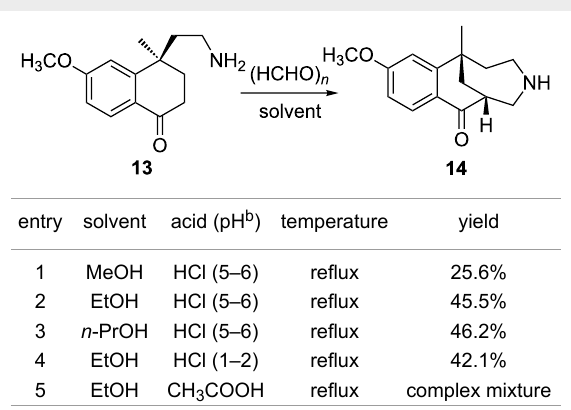
Table 3: Optimization of Mannich cyclization.